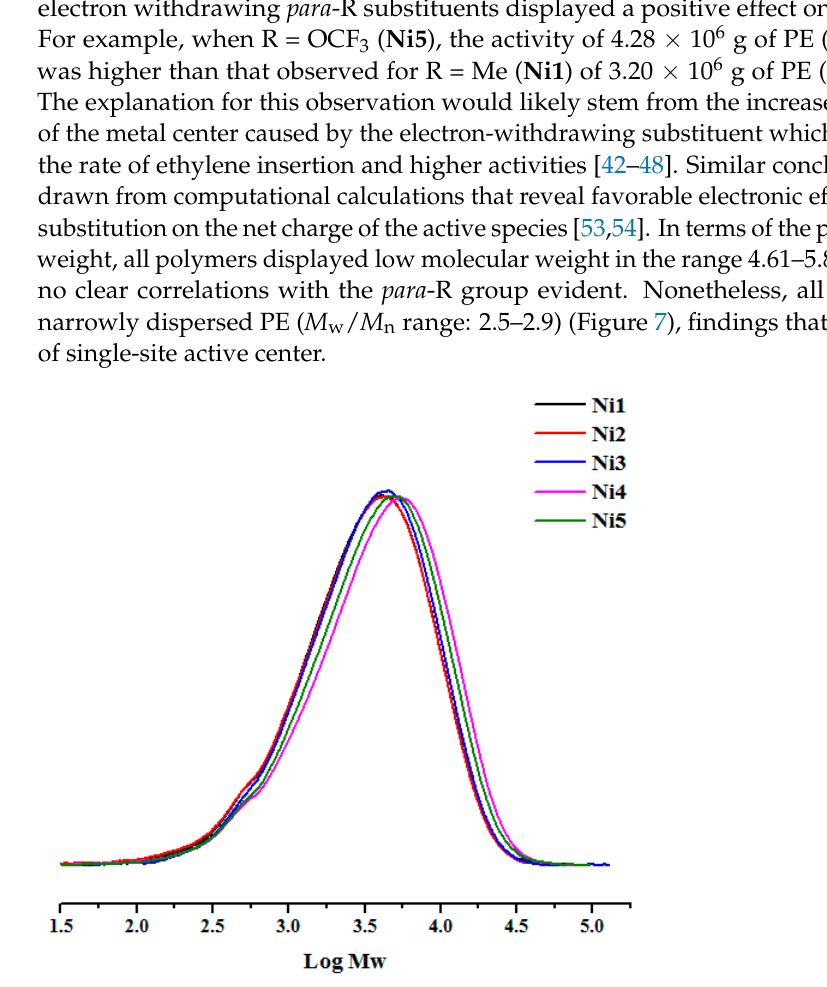
Figure 7. GPC curves of the PE produced using Ni1–Ni5 in combination with EtAlCl 2 under optimized conditions (runs 4, 16–19, Table 3).